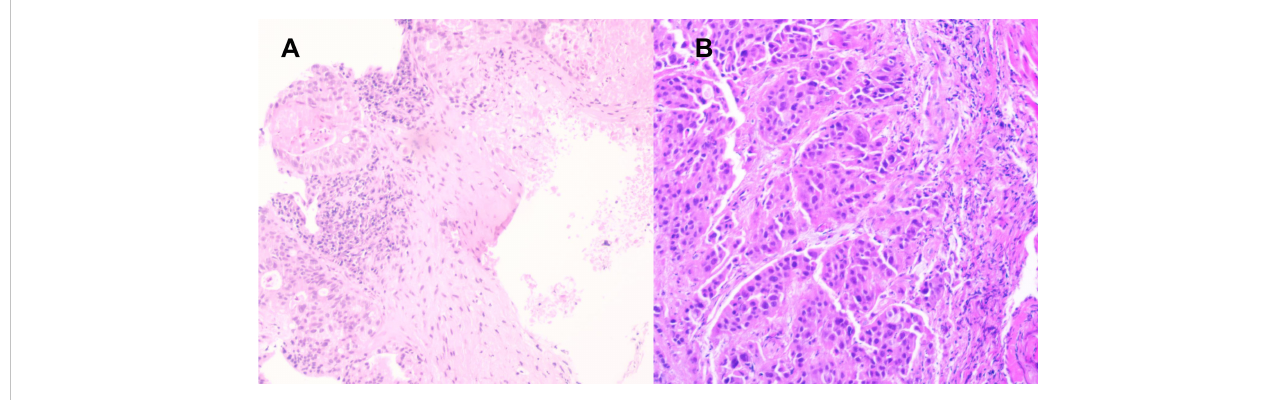
FIGURE 2 Histological fi ndings with hematoxylin and eosin-stained biopsy specimen from biopsy on June 6 th , 2022 ( A , × 200), and surgery on September 6 th , 2022 ( B , ×